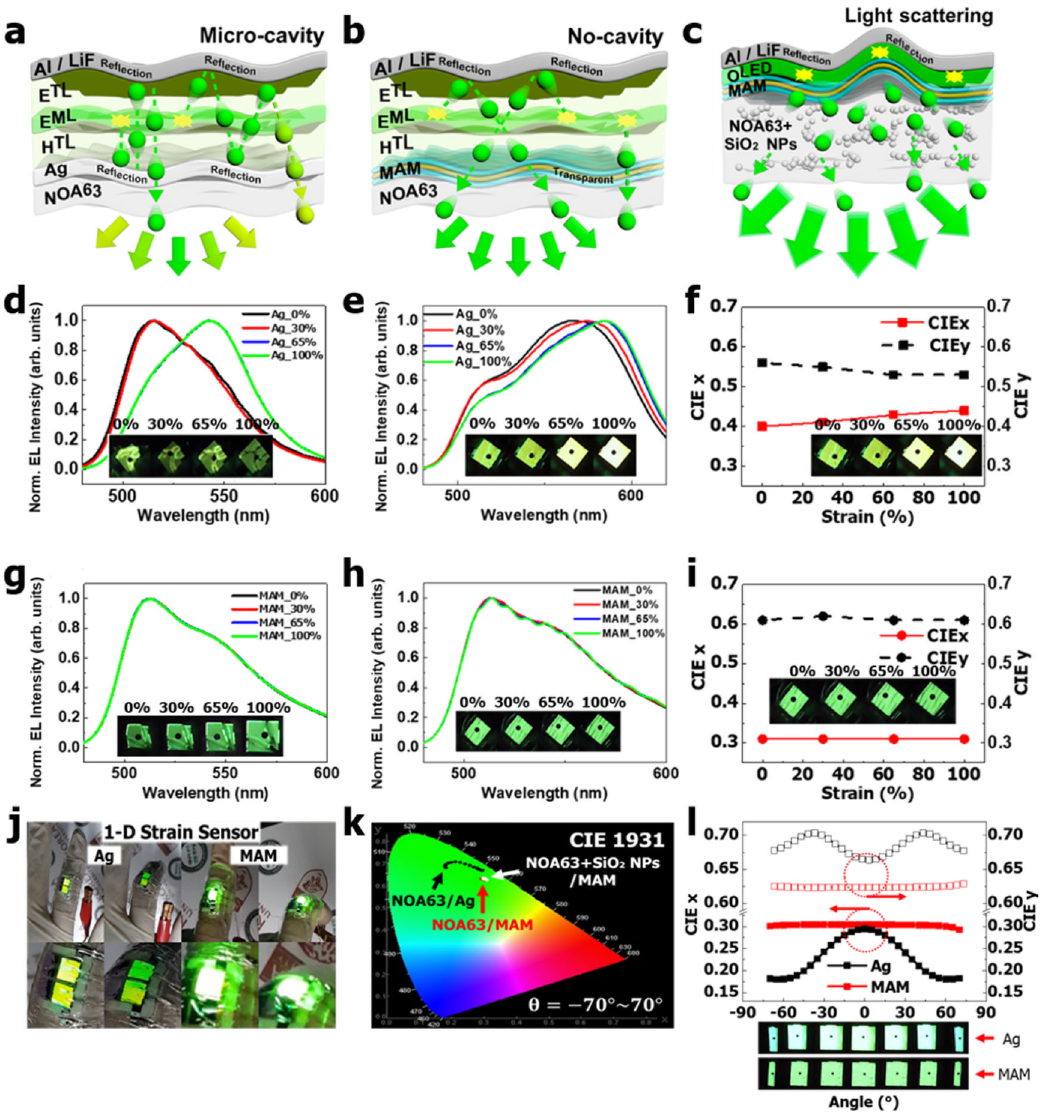
Fig. 6 Mechanism of optical light scattering along with the EL and color coordinate analysis. a – c Schematic illustration of the optical waveguide demonstrating the difference between light pathways for silver (Ag), MoO 3 /Au/MoO 3 (MAM) and MAM with silicon dioxide nanoparticles (SiO 2 NPs) substrates. d , e Electroluminescence (EL) analysis of the devices with Ag electrodes under two-dimensional (2D) and one-dimensional (1D) stretching, respectively. Inset, the camera images of the relevant pixels from the devices. f The changes in the International Commission on Illumination (CIE)-1931 measurements for x and y -coordinates using 1D stretching at various values (0 – 100%). g , h EL analysis of the devices with MAM electrodes under 1D and 2D stretching, respectively. Inset shows the camera images of the relevant pixels from the devices. i The CIE-1931 for x and y -coordinates using 1D stretching at various strain percentages (0 – 100%). j Camera images for 1D strain sensor showing color shift for Ag-based devices, while no color shift for MAM-based devices. k , l CIE-1931 shifts for Ag and MAM electrodes at various measurement angles ( − 70° – 70°) along with the comparison of CIE-1931 for Norland Optical Adhesive 63 (NOA63), with and without SiO 2 NPs/MAM and Ag